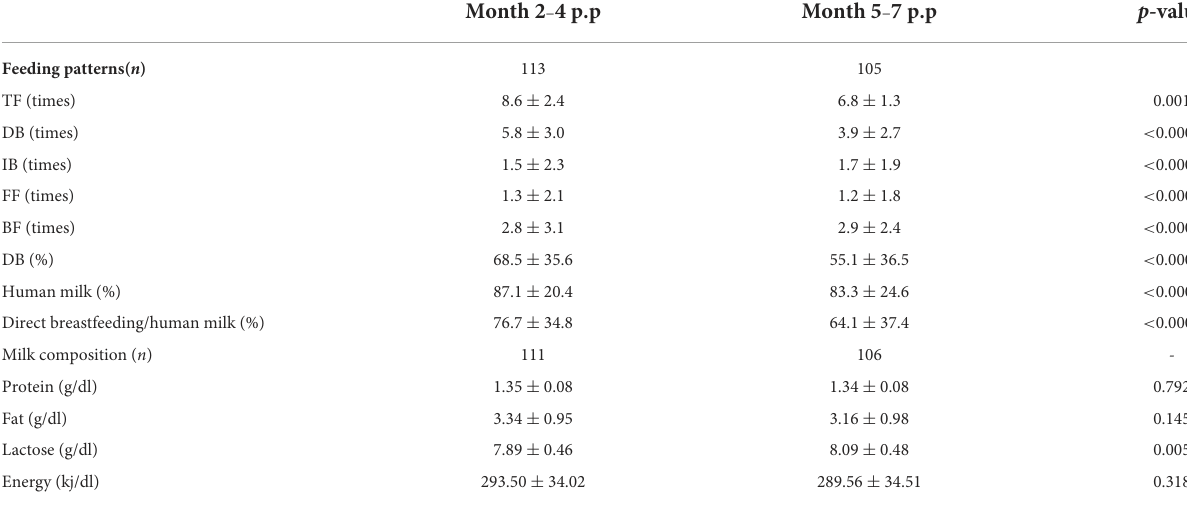
TABLE 1 Feeding patterns and milk macronutrients of the subjects in the longitudinal cohort.